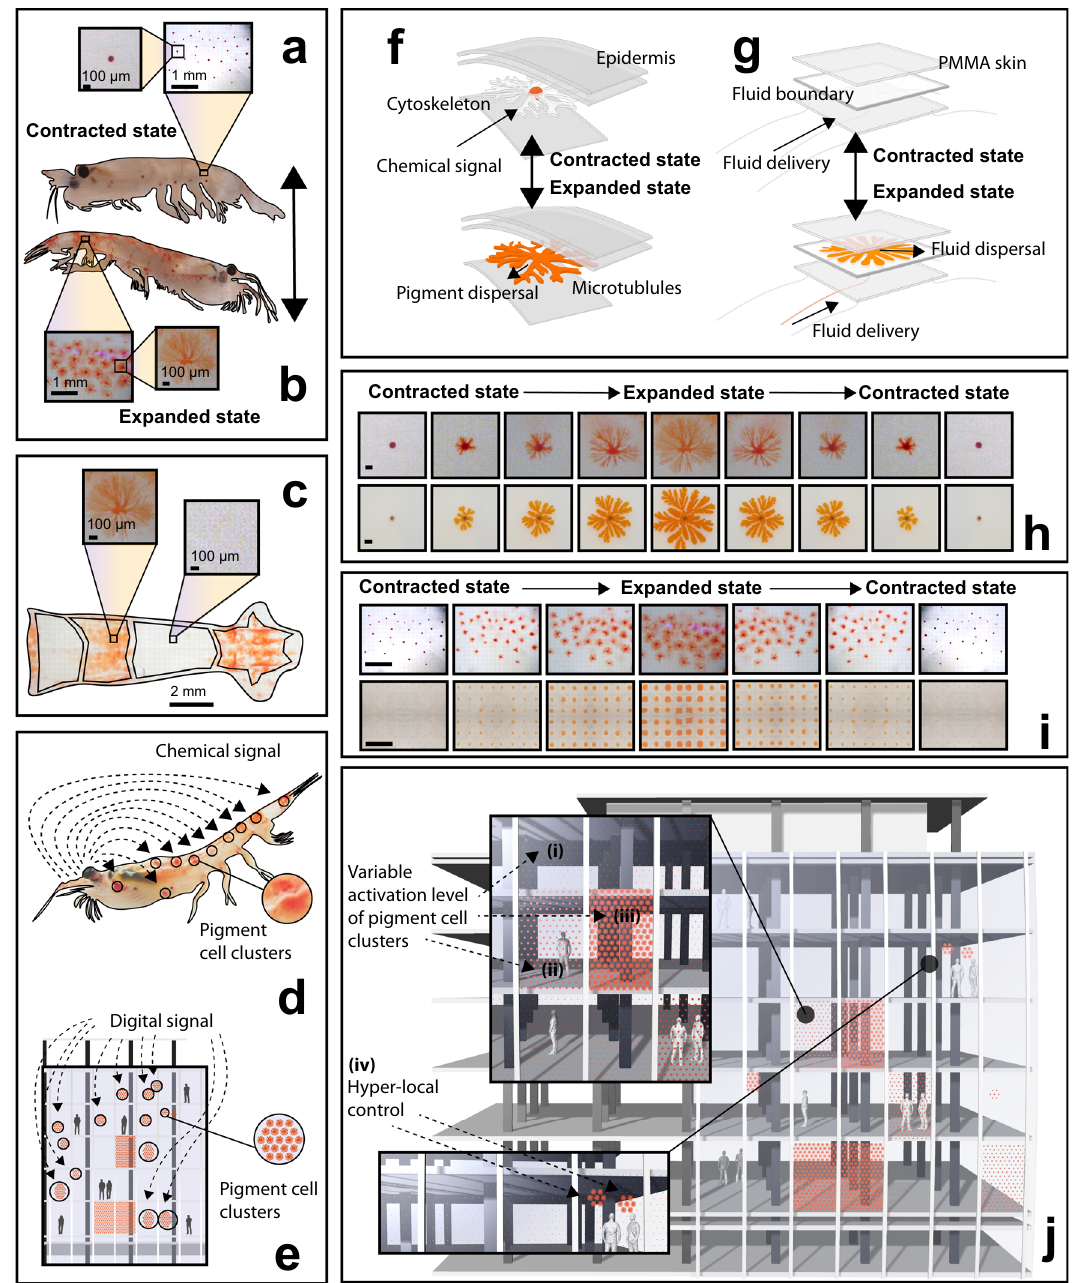
Fig. 1 Biological inspiration for active pigment dispersal in buildings. a , b Reversible chromatophore activation in male Antarctic Krill when unexposed ( a ) and exposed to light ( b ) as a mechanism for dynamic solar shading. c Localized chromatophore coverage of the abdominal segments in Krill. d , e Schematic comparing the activation pathways for both biological chromatophore clusters in Krill ( d ) and synthetic chromatophore clusters in buildings ( e ), to control the ingress of solar radiation through the skin of Krill ( d ) and facade of buildings ( e ). f , g Exploded perspectival cross-section showing both the contracted (top) and expanded (bottom) state of a single chromatophore in both Krill ( f ) and synthetic device ( g ). h Images comparing complete chromatophore expansion and contraction sequence in both Krill (top) and synthetic device (bottom). Top scale bar is 100 μ m. Bottom scale bar is 2 cm. ( i ) Images comparing complete expansion and contraction sequence for a cluster of chromatophores in both Krill (top) and synthetic device (bottom). Top scale bar is 1 mm. Bottom scale bar is 5 cm. Bottom image is stitched from four images of a 4 × 3 pixel array. j Render showing dynamic and localized synthetic chromatophore activation within a building facade, where multiple activation states (i, ii, iii) and hyper-local control (iv) can be achieved. All images of Antarctic Krill in a-d, h-i were provided by Lutz